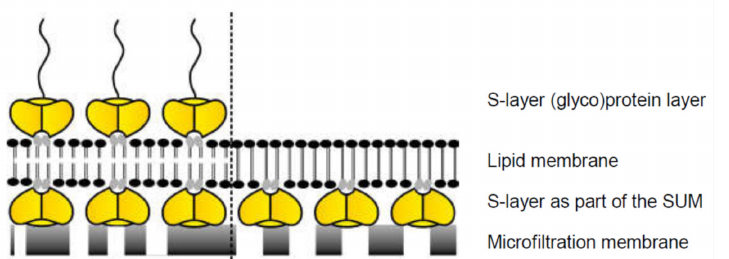
Figure 8. Schematic drawing of lipid membranes on S-layer (yellow)-covered microfilters. Some head groups of the lipid molecules within the membrane (gray) interact electrostatically with certain domains on the S-layer lattice. A further (glyco)protein S-layer lattice can be recrystallized on the outer leaflet of the lipid membrane (left). In analogy, some head groups of the lipid molecules within the membrane (gray) interact electrostatically with certain domains of the S-layer proteins. The lipid molecules on the left side depict schematically phospholipids, whereas the lipid molecules on the right side indicate tetraether lipids. (With permission from Ref. [6] (CC BY-NC-ND